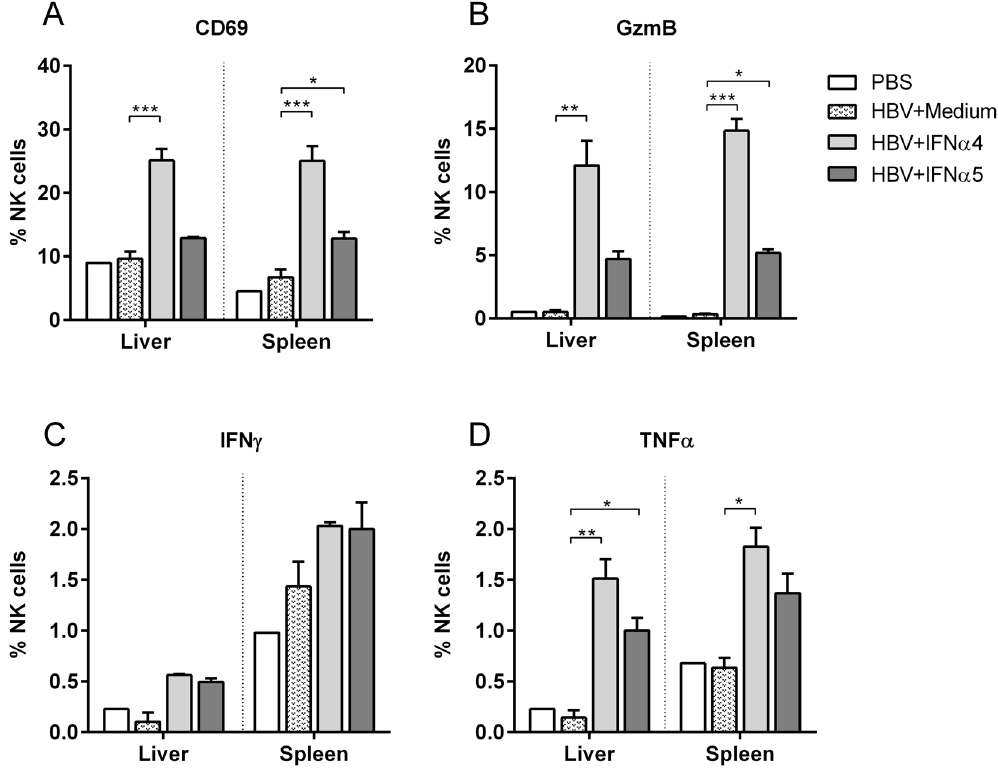
Figure 3. Analysis of NK cells from IFN α 4 or IFN α 5-treated mice. Mice received HI with 10 µ g of pAAV- HBV1.2 plasmids. Mice were treated i.p. with 8000 units of recombinant IFN α 4 or α 5 protein starting from days − 1 to 3 post HI. Control mice received either HI with PBS (PBS) or were treated i.p. with media (HBV + Medium). At day 4 post HI mice were sacrificed and nucleated cells from liver and spleen were analyzed by flow cytometry for expression of NK cell-specific surface markers and intracellular cytokines. ( A ) The percentage of activated CD69 + NK cells, ( B ) GzmB, ( C ) IFN γ and ( D ) TNF α -producing NK cells were shown. At least four mice per group were analyzed. Differences between the groups were analyzed by using the One-way ANOVA. Statistically significant differences between the IFN-treated groups and the untreated control group are indicated by * for p < 0.05, ** for p < 0.01 and *** for p <